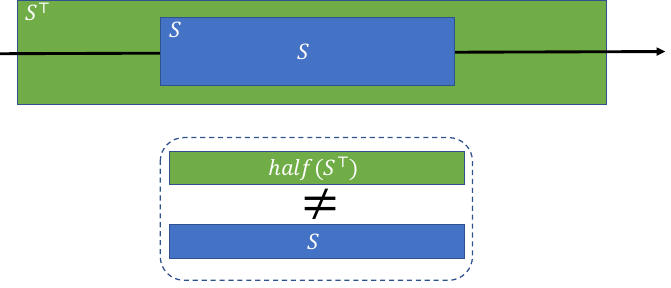
Figure 4. Local salience of a subsequence S implies that it is well defined in its immediate neighbor- hood; S is different from a larger subsequence centered around the same time